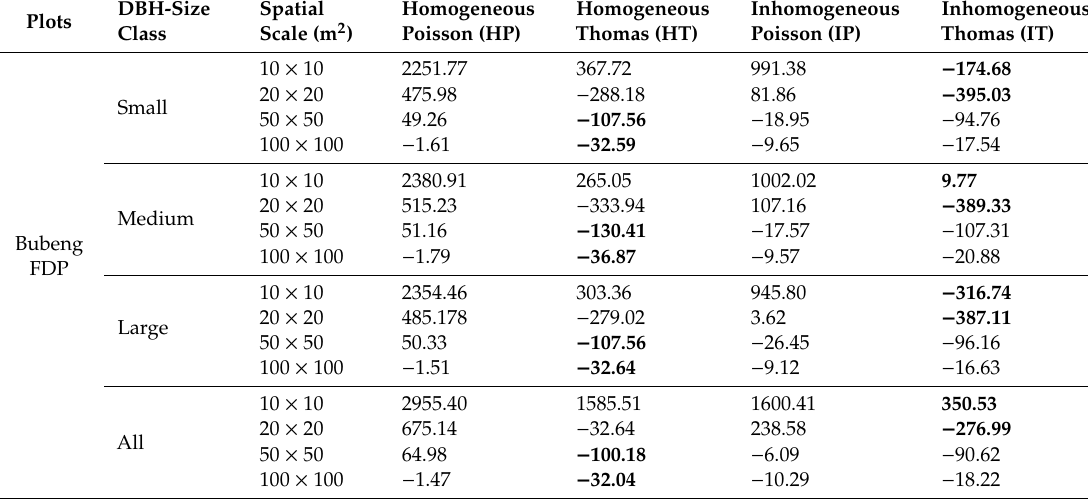
Figure 2. Real and simulated species beta diversity across DBH-size classes at different spatial scales in the Ailaoshan plot. Table 1. Akaike’s information criterion (AIC) values of the spatial point pattern models for species beta diversity across DBH-size class and scales in the two forest dynamics plots.